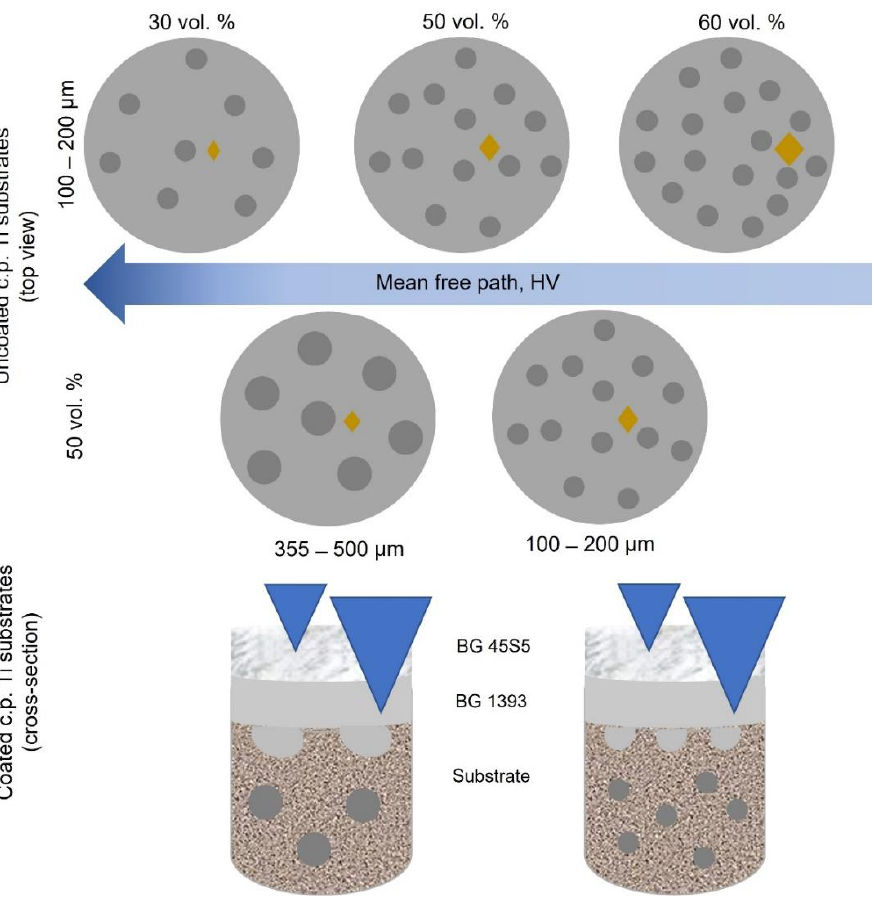
Figure 5. Scheme of the influence of the percentage of porosity and the average size of the pores on the mean free path and mechanical behavior.